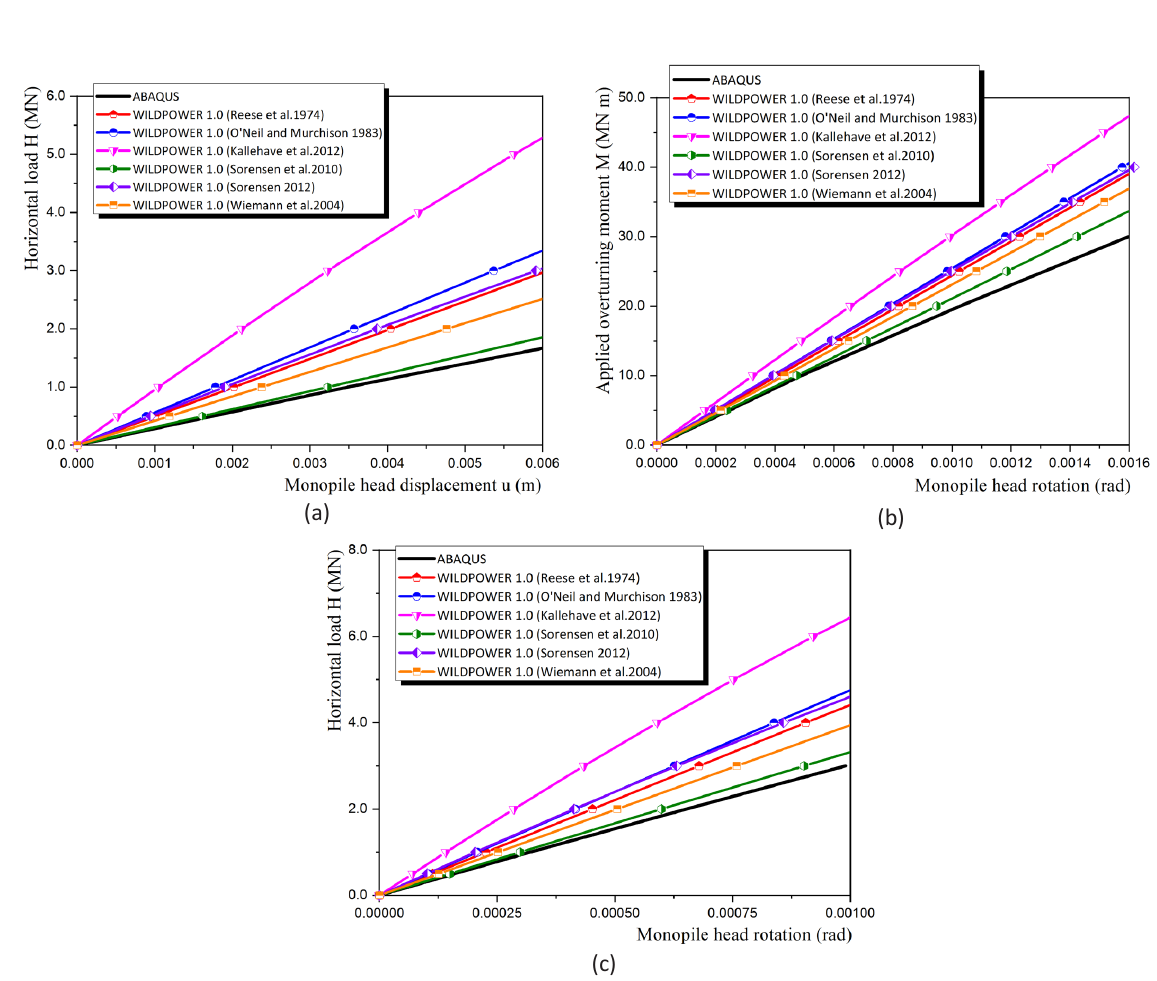
, (b) M - θ and (c) H - θ L R R